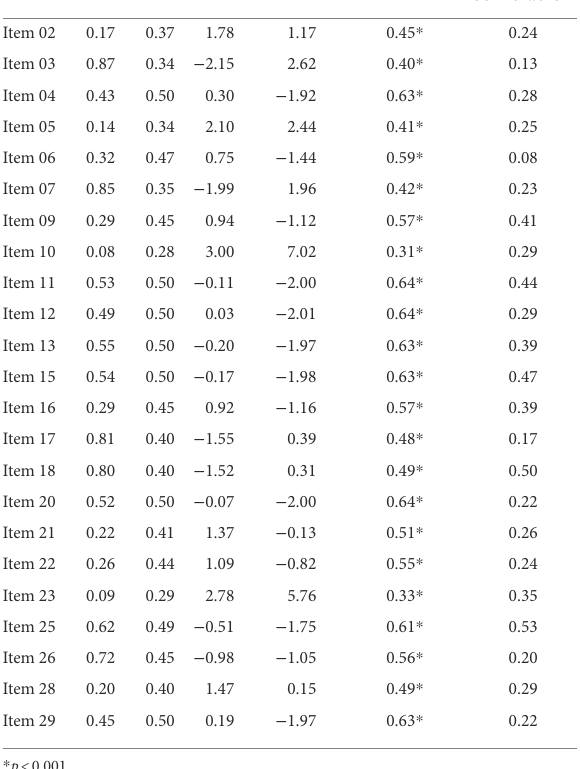
item-total correlation